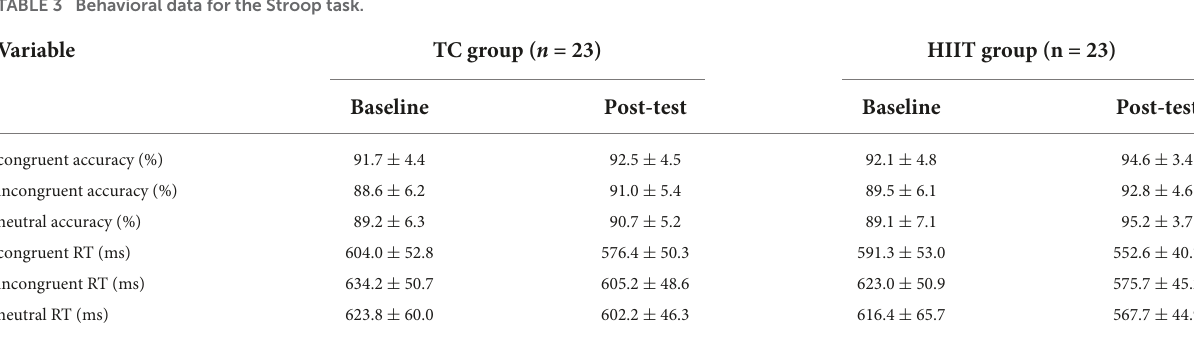
TABLE 3 Behavioral data for the Stroop